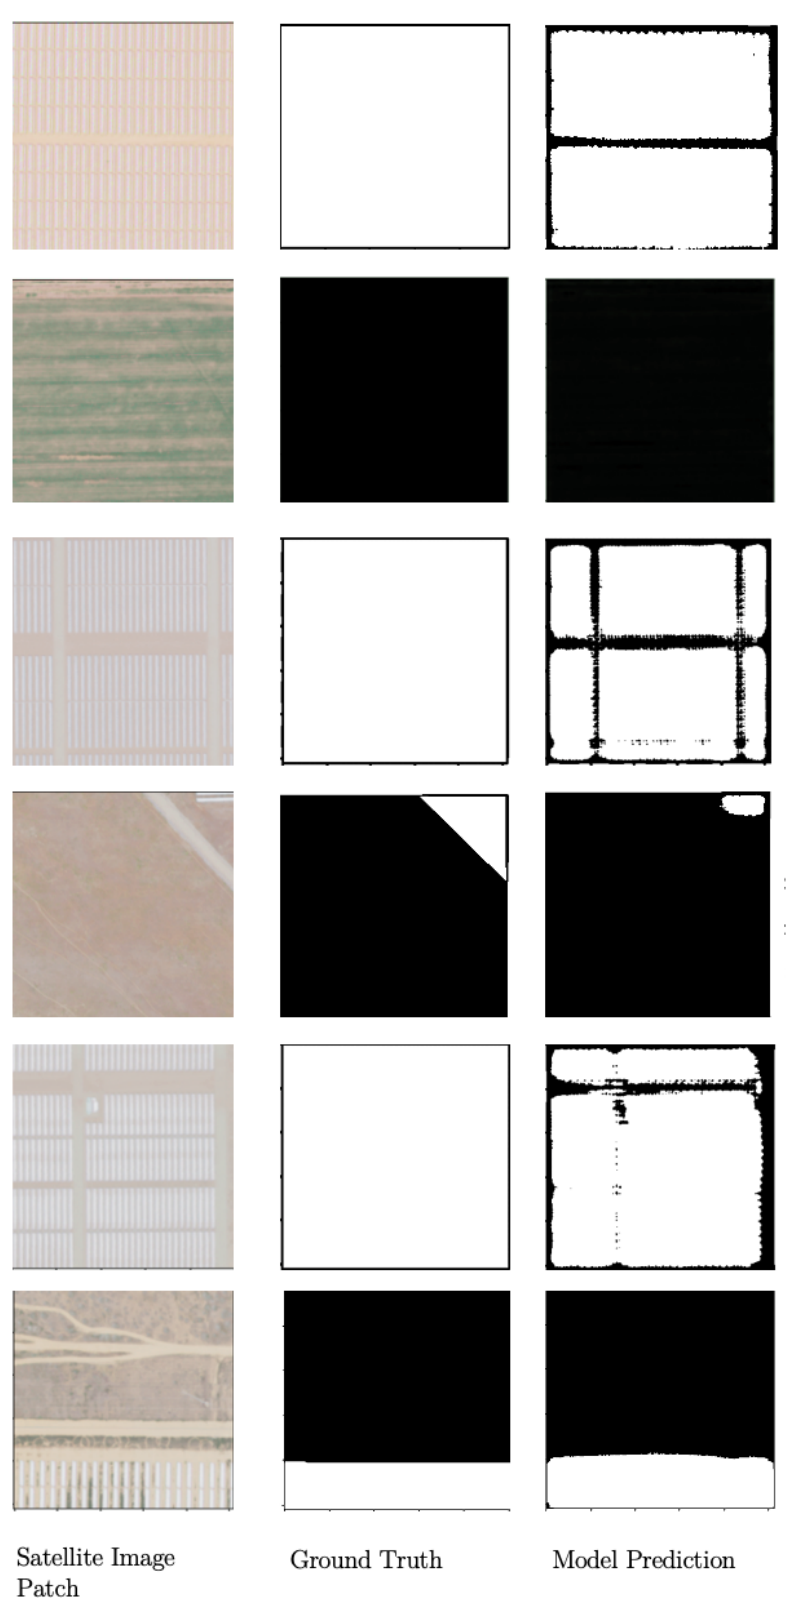
Figure 7. Predictions on individual patches (before postprocessing) show clearer outputs than human labeling (ground